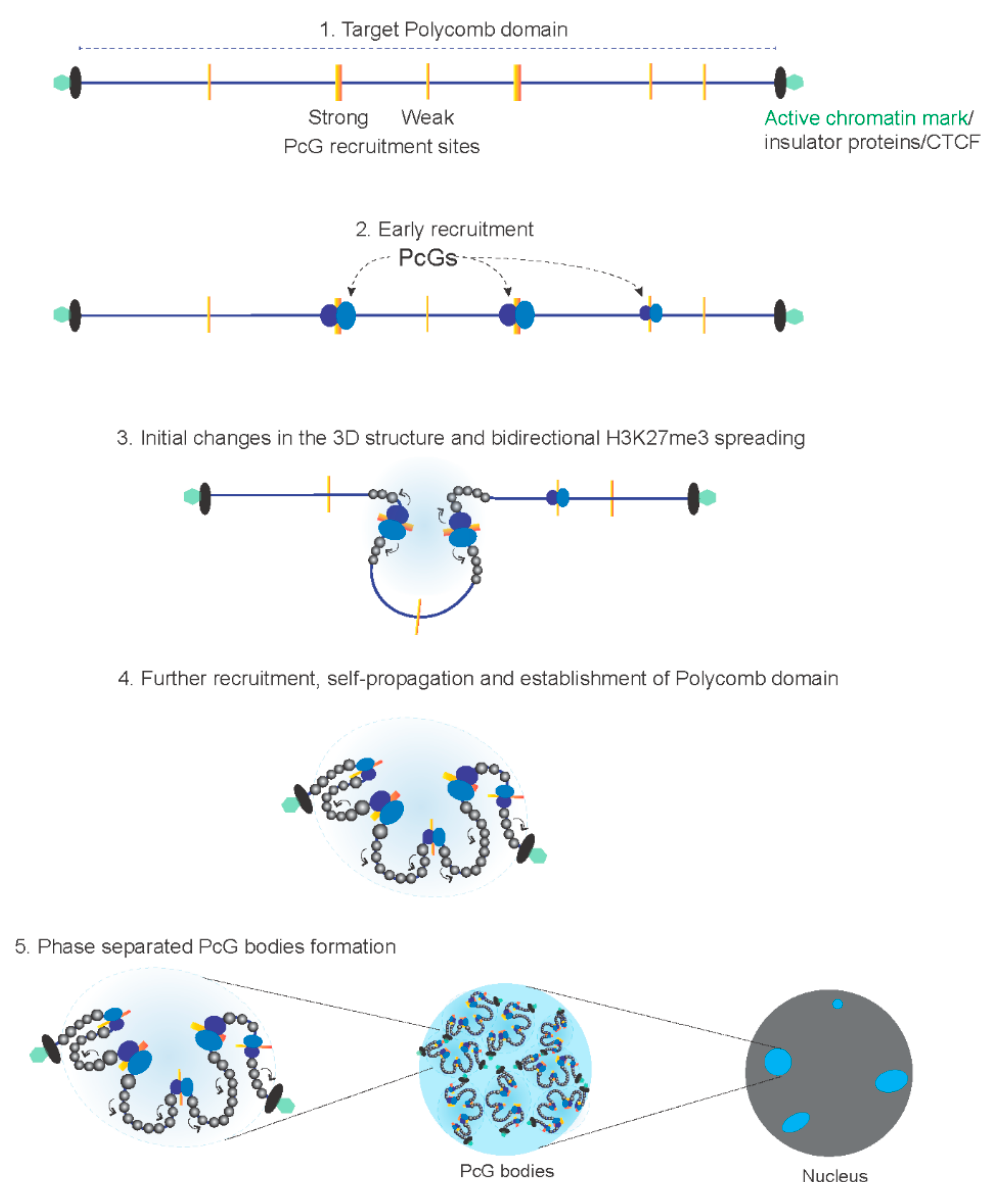
Figure 2. Polycomb domain establishment. ( 1 ) PcG recruitment sites (strong and weak) within a target Polycomb domain, PcG domain boundaries: in Drosophila, either actively transcribed genes or insulator proteins act as boundaries, and in mammals, CTCF proteins act as boundaries; ( 2 ) initially, PcGs are recruited to PcG recruitment sites, predominantly to the strong sites; ( 3 ) 3D structural changes occur due to PcG recruitment, and H3K27me3 spreads bi-directionally from these sites; ( 4 ) further recruitment leads to H3K27me3 spreading throughout the domain in a feed-forward mechanism, and induces widespread structural changes; ( 5 ) phase separated PcG bodies are formed throughout the nucleus. Adapted from Kuroda et al. [28].